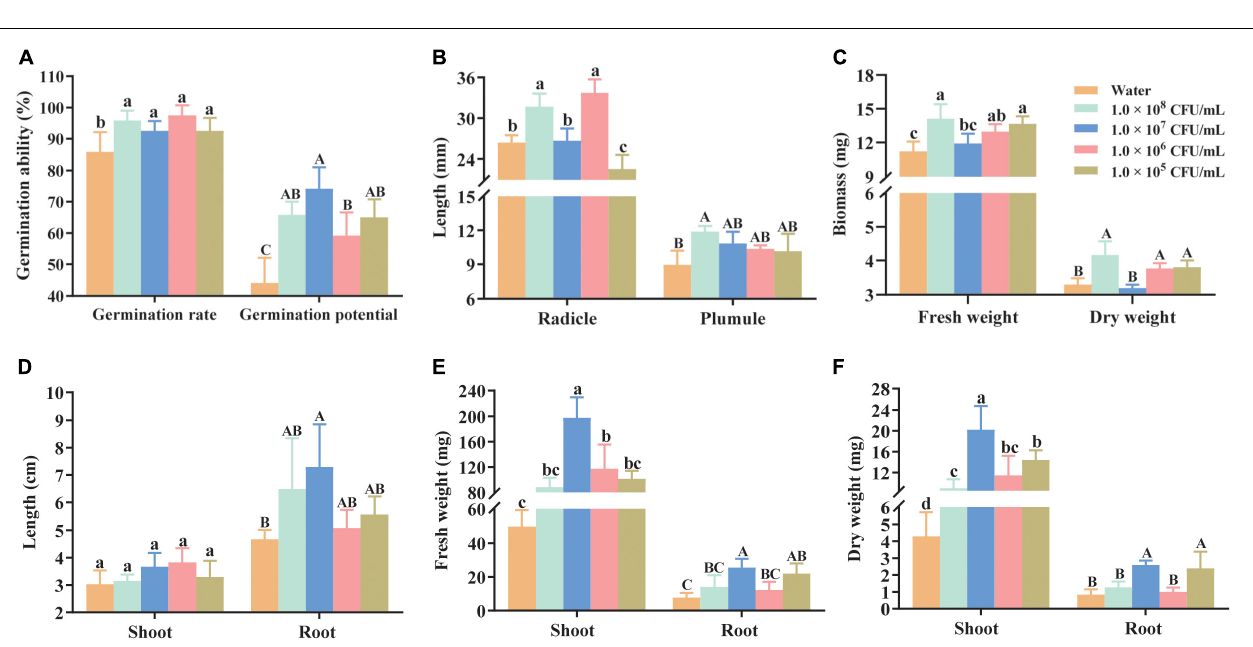
FIGURE 5 | Effects of B. megaterium HGS7 on the germination of mulberry seeds and seedling growth. (A) Germination rate and potential of mulberry seeds. (B) Radicle and plumule length from germinated mulberry seeds. (C) Fresh and dry weight of germinated mulberry seeds. (D) Shoot and root length of mulberry seedlings. (E) Fresh weight of root and shoot of mulberry seedlings. (F) Dry weight of shoot and root of mulberry seedlings. Data represent mean ± standard deviation ( n = 3). Different letters indicate treatments that exhibited significant differences at P < 0.05.